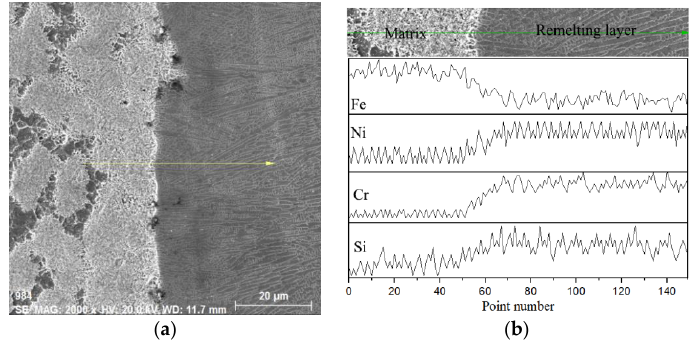
Figure 5. Line scan results: interface after laser remelting at 500 W. ( a ) Line scanning; ( b ) Line scan results.